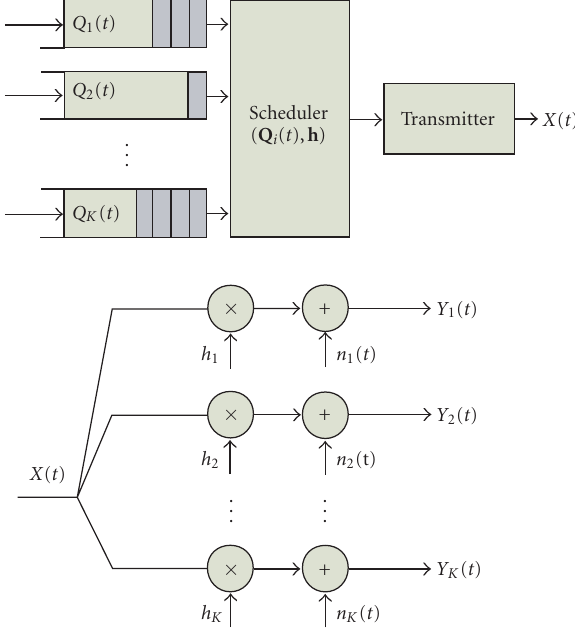
Figure 1: System